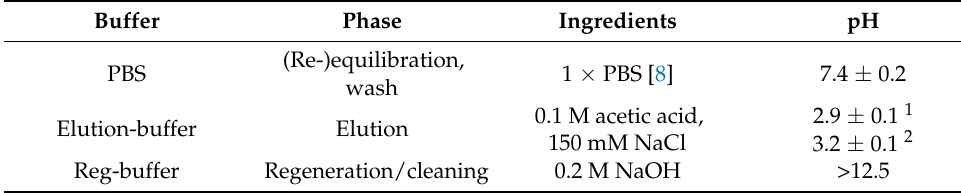
Table 1. Buffers utilized for the chromatographic